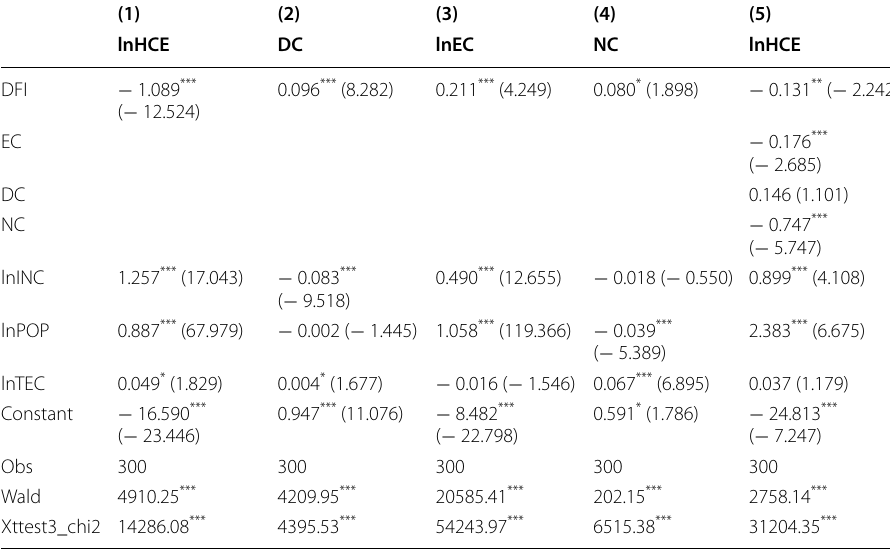
The values in parentheses represent the t-statistics * , ** , *** imply the significance at the 10%, 5%, and 1% levels, respectively.